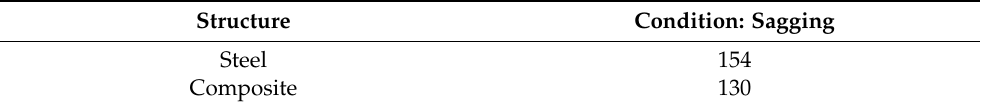
Table 10. Static displacement.